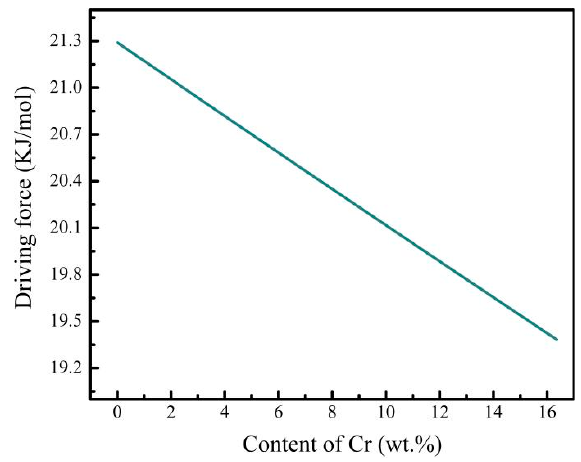
Figure 6. Calculated variation of driving force of α phase precipitation with Cr content.